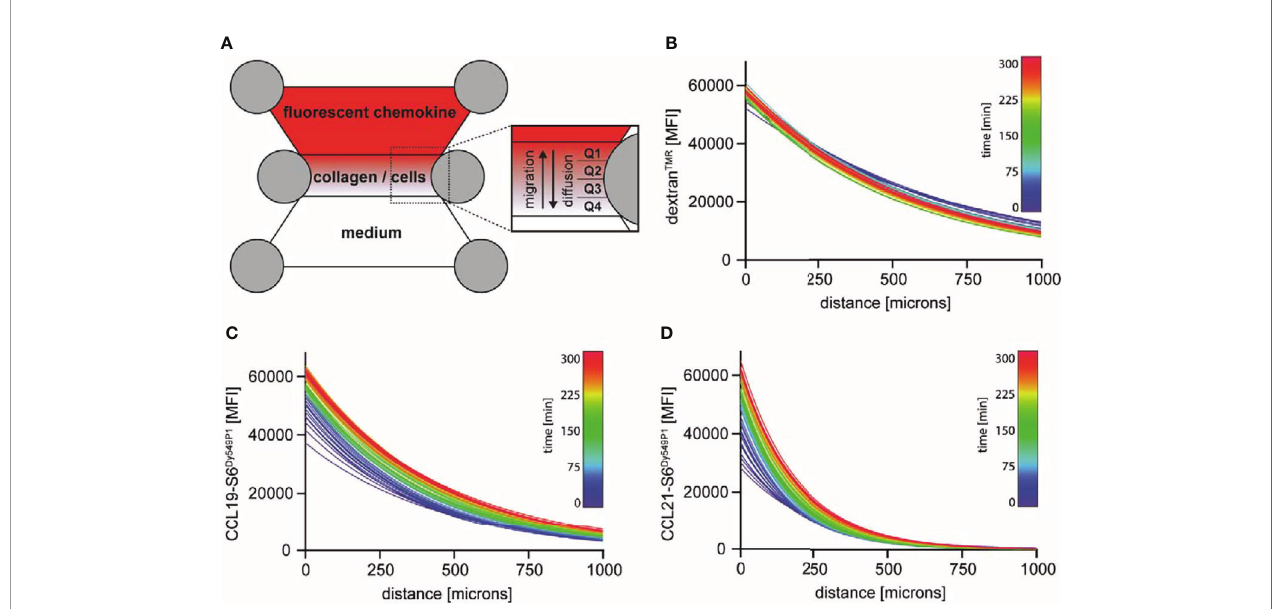
FIGURE 1 | Visualization and characterization of fl uorescently labelled dextran, CCL19 and CCL21 gradients in 3D migration chambers. (A) Schematic representation of a 3D migration chamber. Cells are embedded in a de fi ned 3D collagen I matrix of an Ibidi m -slide suitable for time-lapse fl uorescence microscopy. Fluorescently labelled molecules and control medium are fi lled into the adjacent connected reservoirs, such that a gradient is established over time following a source-and-sink principle. The central chamber corresponds to the observation area, which we subdivided into four quarters (Q1-Q4) for certain analysis. (B-D) Distribution of fl uorescently labelled molecules in the central observation chamber was measured by time-lapse fl uorescent microscopy. One reservoir was fi lled with 100 nM dextran TMR (B) , CCL19-S6 Dy549P1 (C) or CCL21-S6 Dy549P1 (D) . Mean fl uorescence intensity (MFI) of the labelled proteins within the 3D matrix was monitored over time for 5 hours, fi tted with a one-phase decay model and color graded from blue (t = 0min) to red (t = 300min). One out of two independent experiments is